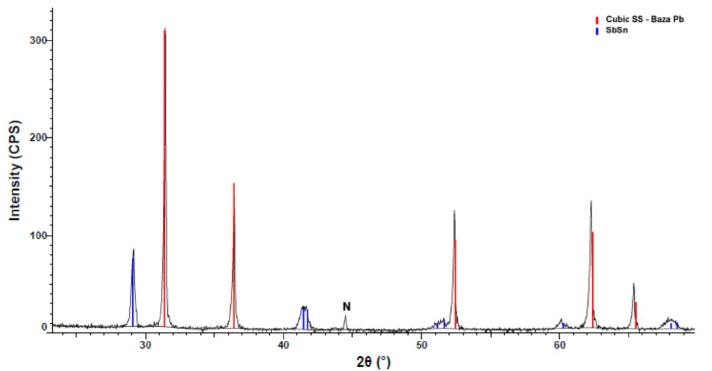
Figure 8. XRD pattern for the sample YP2.